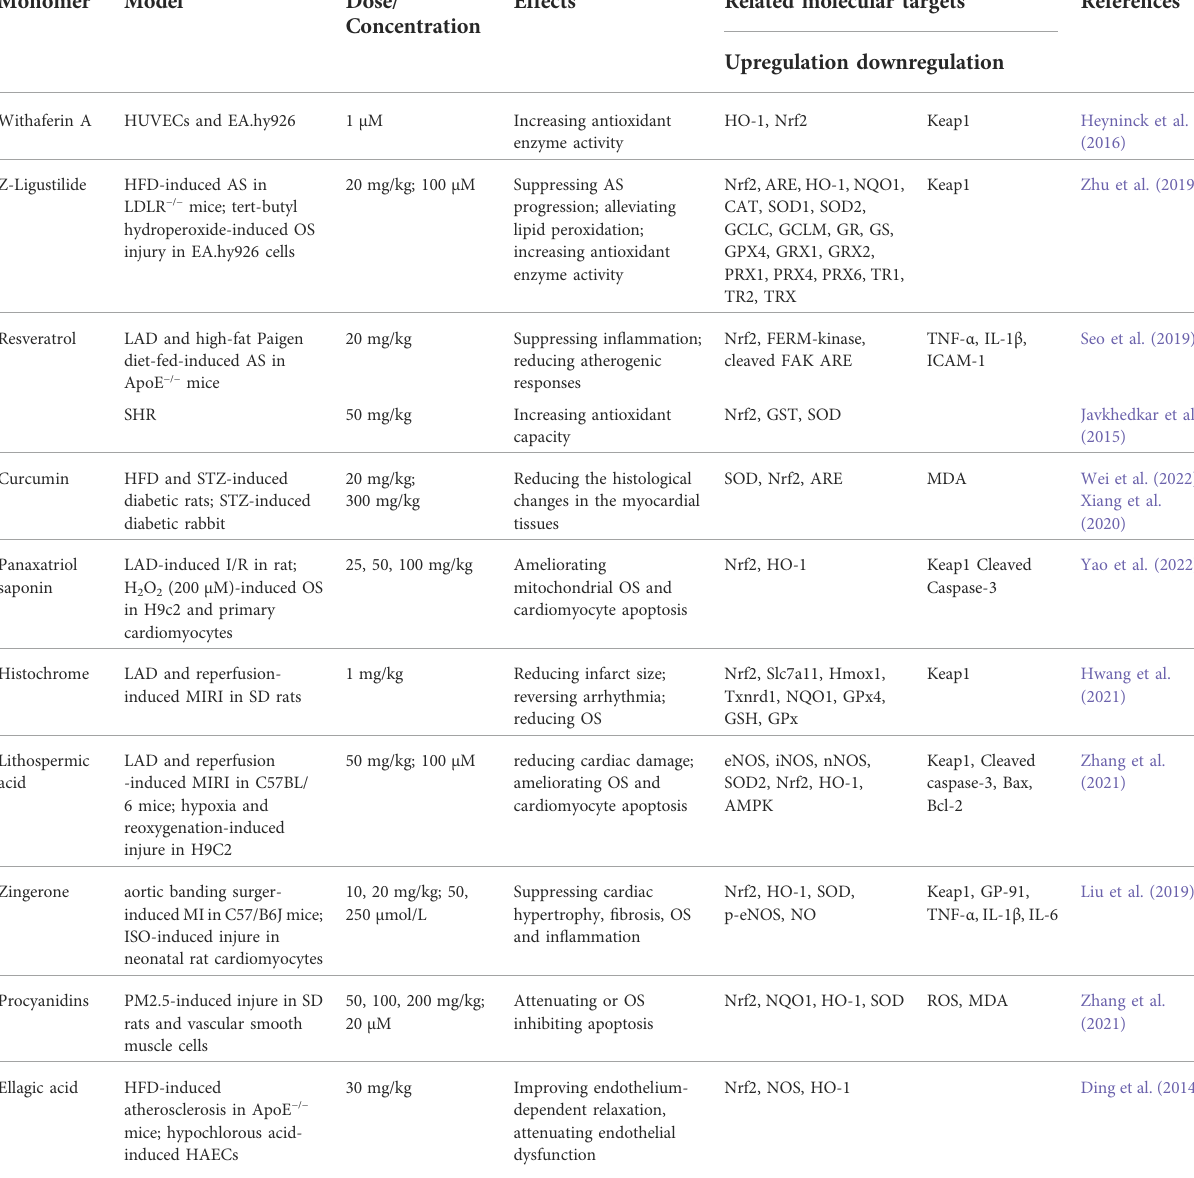
TABLE 6 Protective effects of other monomers from herbal medicines on vascular endothelial